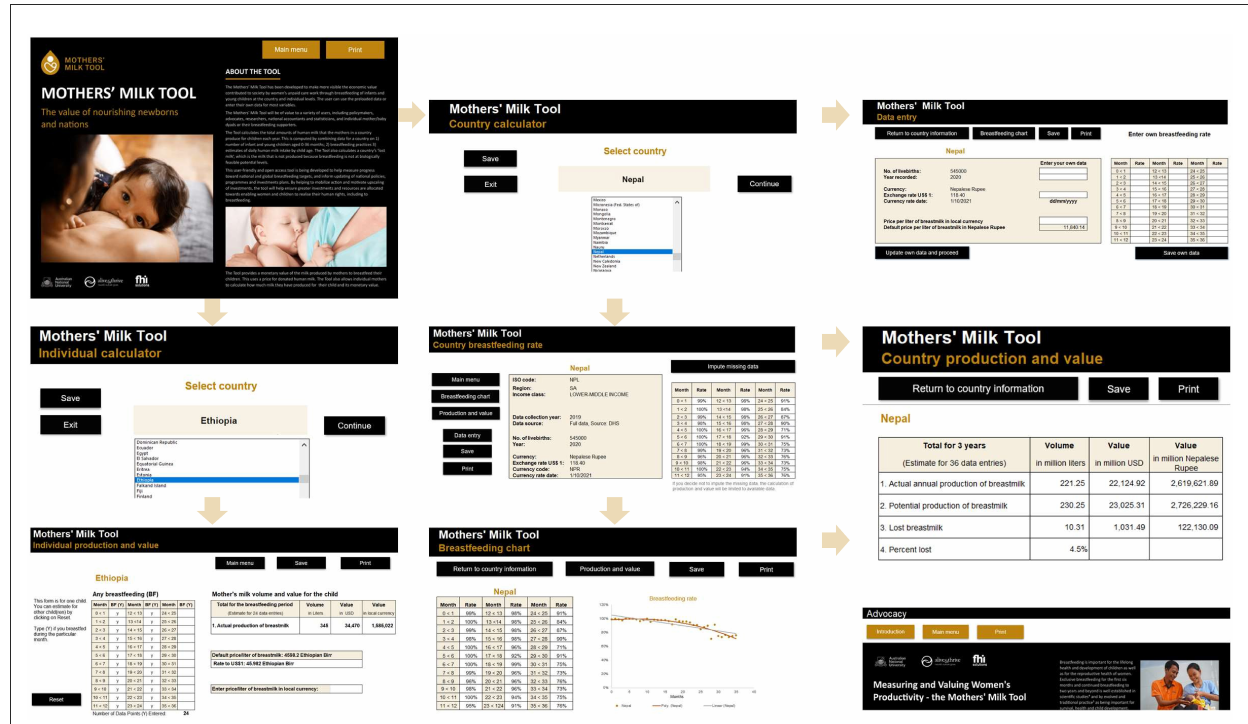
FIGURE1 Key functions of the Mothers’ Milk Tool. Authors created this figure using snapshots of the Mothers’ Milk Tool offline (https://mothersmilktool.org). The human identifiable images are licensed for personal, business or commercial purposes.